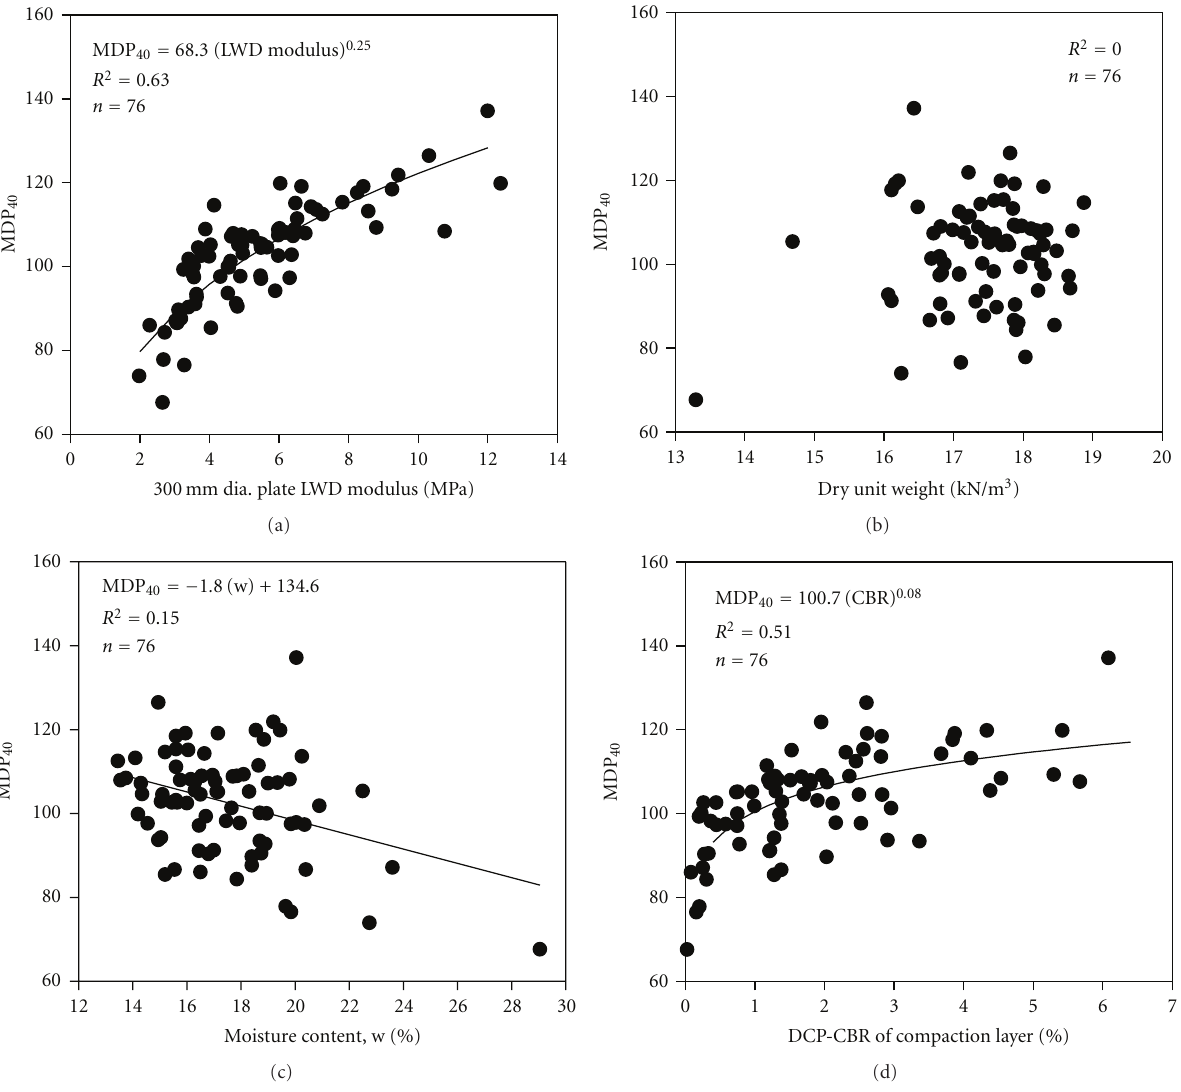
Figure 4: Example 3: Relationships between MDP 40 (obtained in static mode) and in situ point measurements (LWD modulus, dry unit weight, moisture content, and CBR determined from DCP)—Sandy clay to silty clay